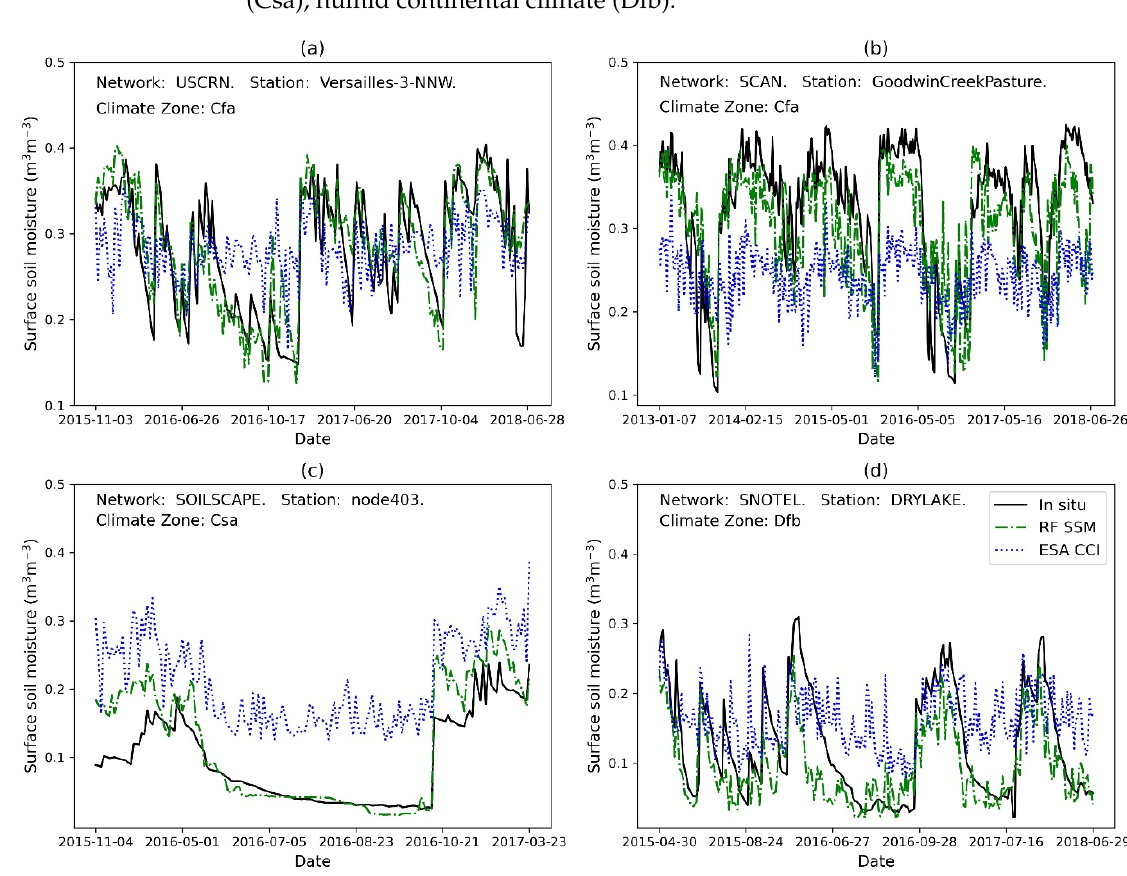
Figure 5. Time-series of predicted SSM at selected stations across various climate zones with RF model II (considering geographical coordinates). ( a ) Station Versailles-3-NNW, USCRN; ( b ) Station GoodWinCreekPasture, SCAN; ( c ) Station Node403, SoilSCA, ( d ) Station DryLake in SNOTEL).